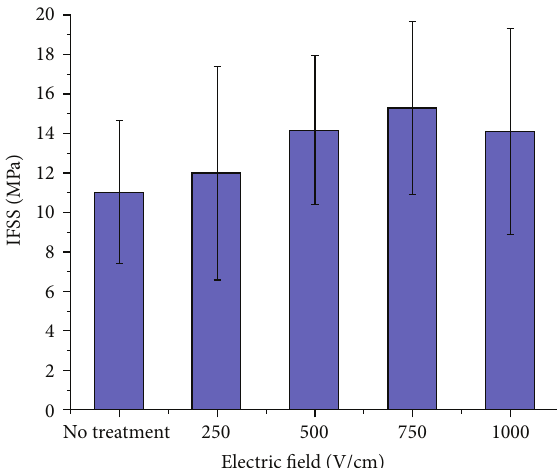
Figure 7: The influence of the AC electric fields treatment on the IFSS between mendong fiber and epoxy thermoset ( 𝑁 = 10 ).